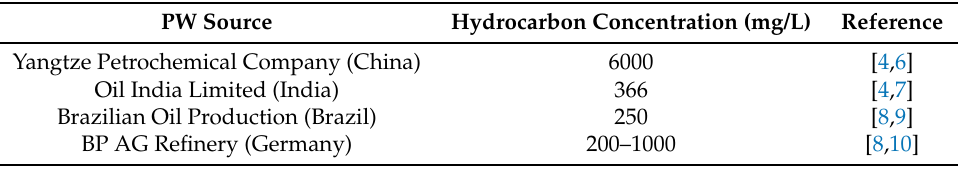
Table 1. Examples of PW